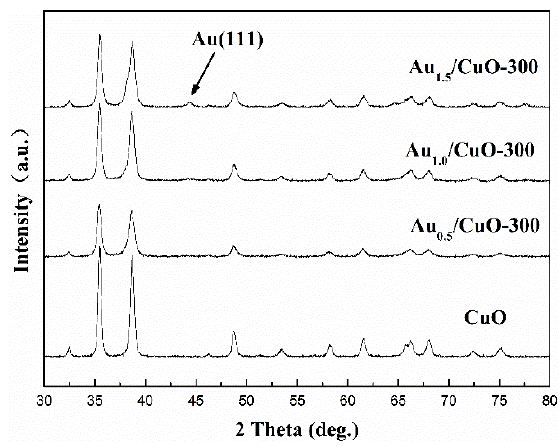
/ CuO-300 catalysts with various gold X